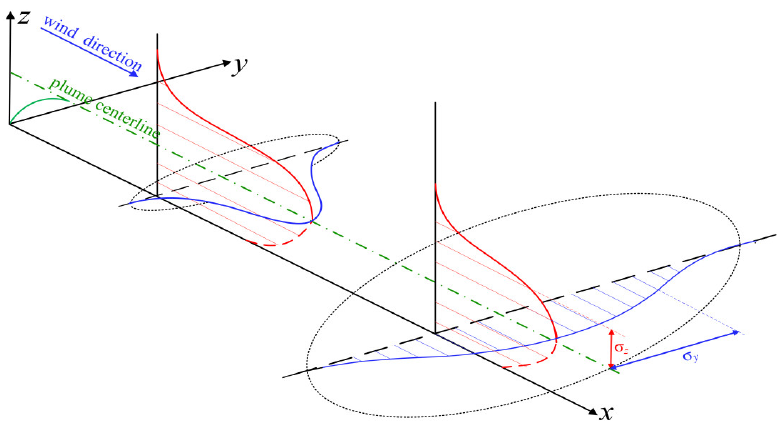
Figure 5. A contaminant plume emitted from a continuous point source, with the wind direction aligned with the x -axis.